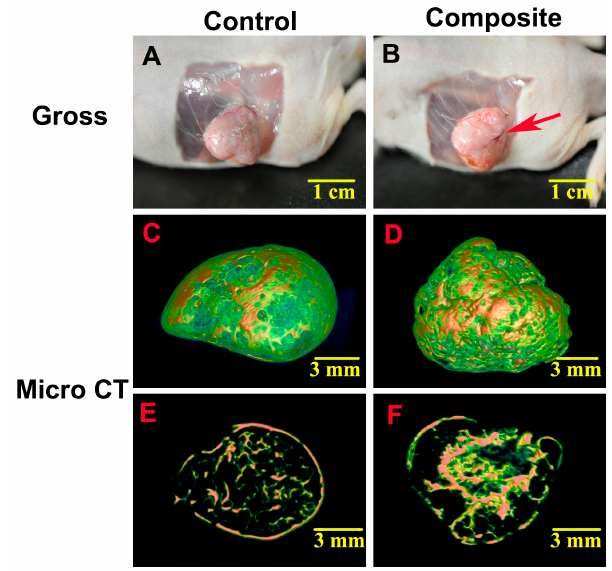
Figure 2. Gross morphology and micro computed tomography (CT) analysis of bone tissue formed in vivo . ( A , B ) On gross examination, the harvested specimens in the composite group were harder than those in the control group, and newly formed blood vessels were clearly observed in the tissue in the composite group (red arrow); ( C , D ) Micro CT images showed that the spongy bone structure in the composite group was much denser than that in the control group; ( E , F ) The cross-sectional micro CT images also indicated that the composite constructs generated more newly formed bone-like tissue than the MSC-only constructs.